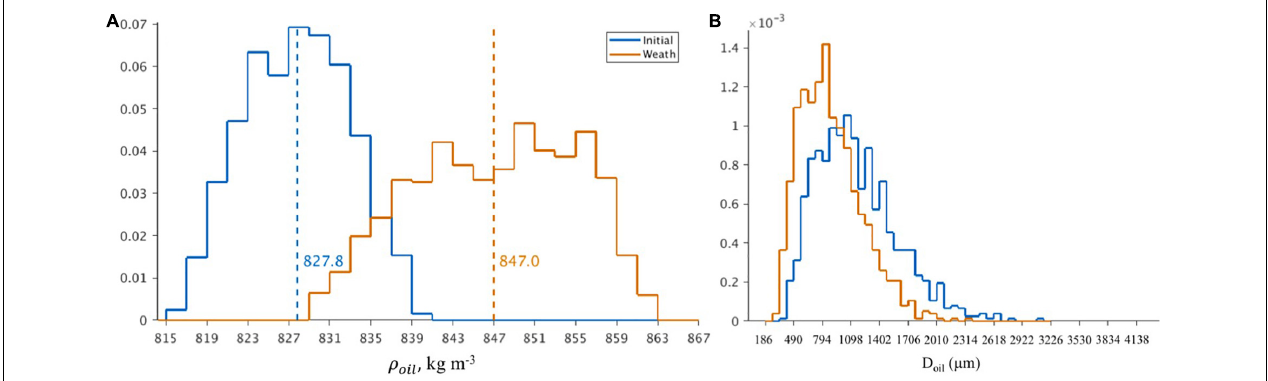
FIGURE 5 | (A) Histograms of the oil droplet densities ( ρ oil ) at the beginning (blue) and end (orange) of a 7 day ROMS-OTWM simulation that includes oil evaporation as the only loss term. Only particles that remained at the surface at least 4 days are considered. The vertical dashed lines indicate the mean. (B) Similar to (A) but for the oil droplet sizes ( D oil ).